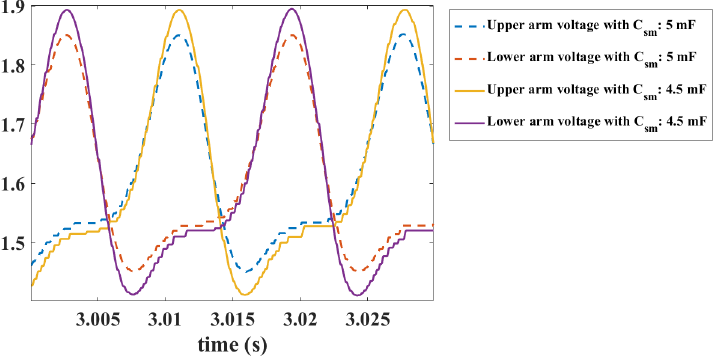
Figure 17. Validation of numerical analysis using PSCAD through observing voltage ripple of the submodule in MMC-HVDC in Jeju MILM